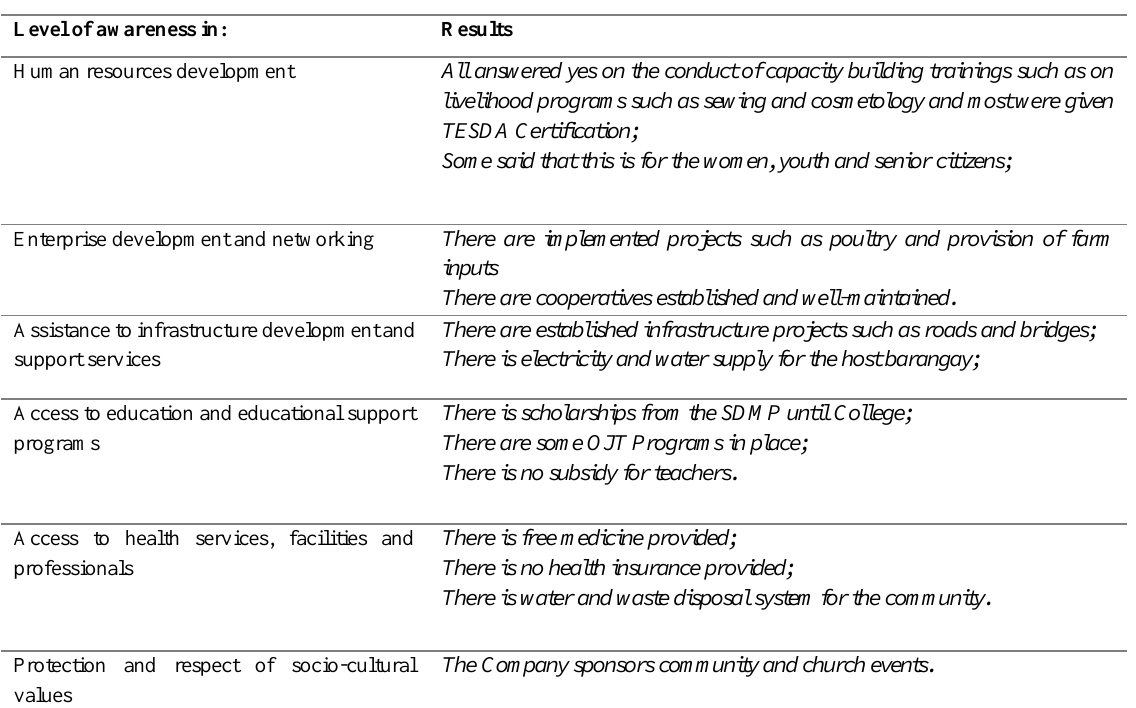
Table 1: Level of awareness of the communities about the Social Development and Management Programs of the